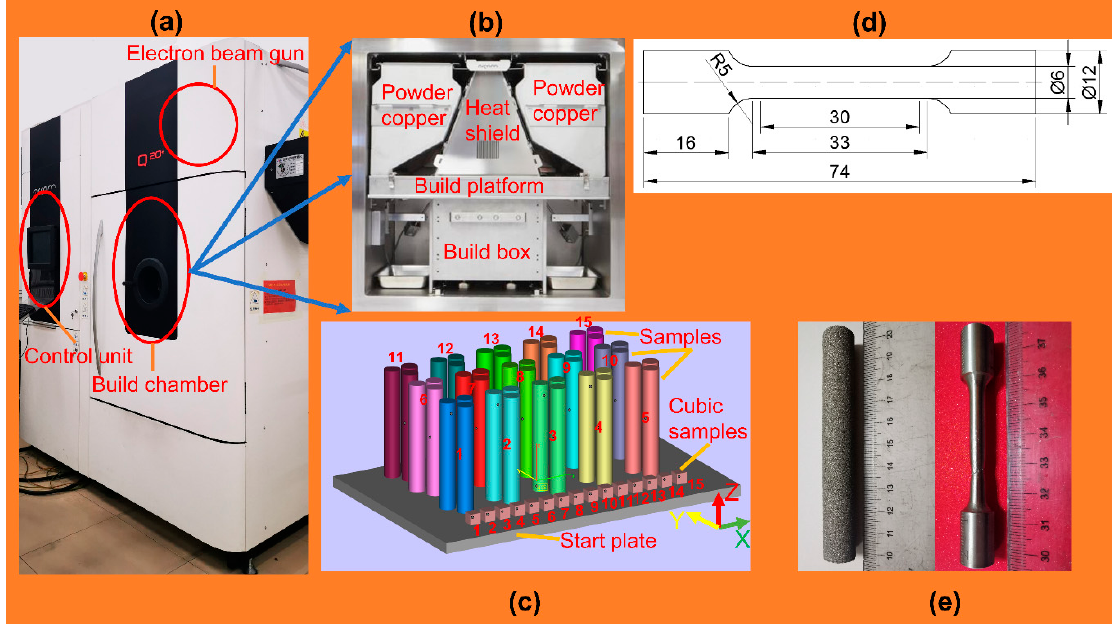
Figure 2. An illustration showing the preparation of Ti-6Al-4V specimens: ( a ) the Aram Q20 machine; ( b ) inter structure of build chamber; ( c ) the layout of specimens in the build chamber; ( d ) geometry shape and size of tensile specimens; ( e ) As-built specimens and the machined ones after a fracture.